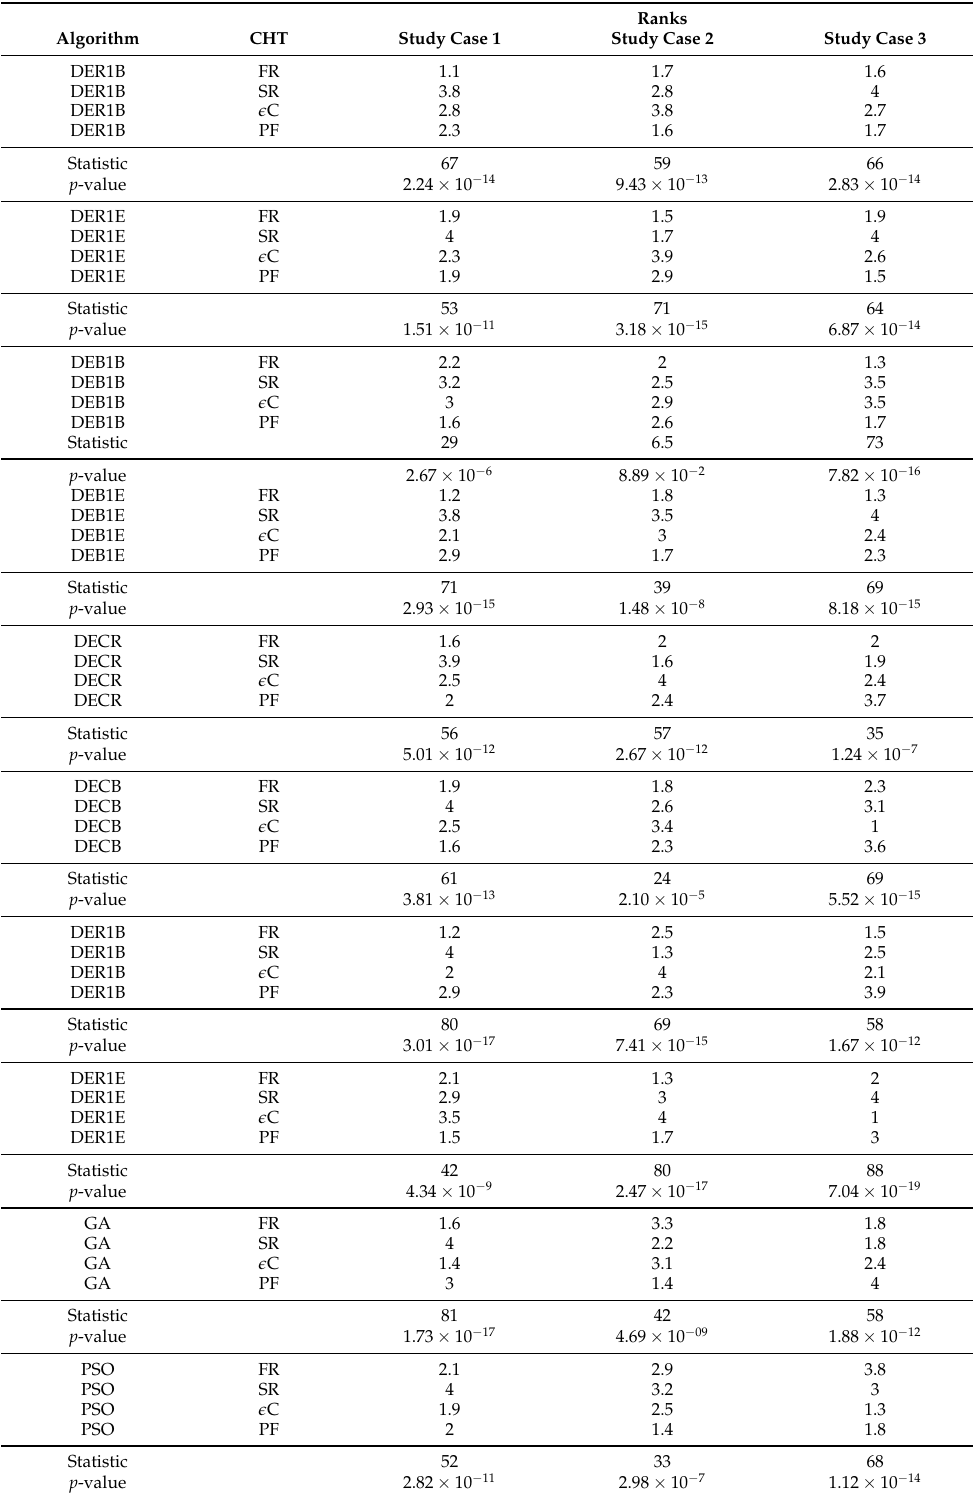
Table A10. Ranks and p -value obtained by the Friedman test . A p -value less than 0.05 indicates that the group of values of the objective function for each algorithm are